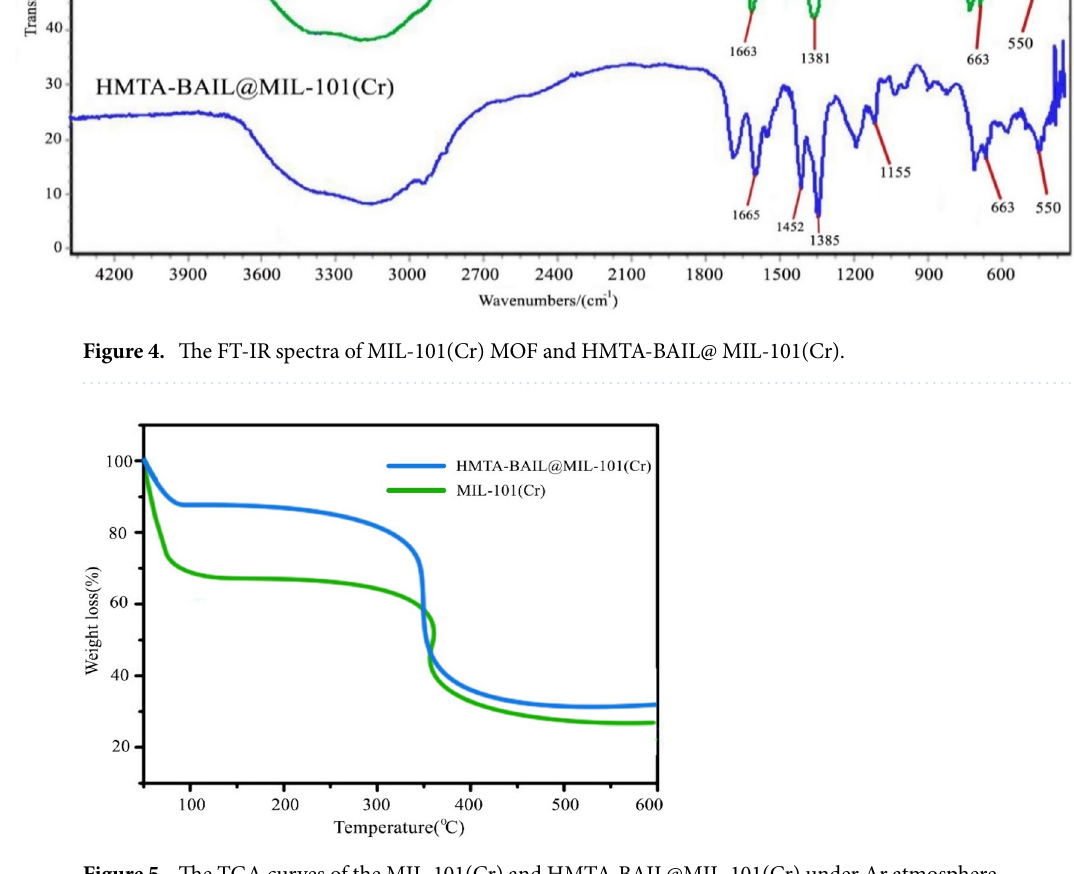
Figure 5. The TGA curves of the MIL-101(Cr) and HMTA-BAIL@MIL-101(Cr) under Ar atmosphere.